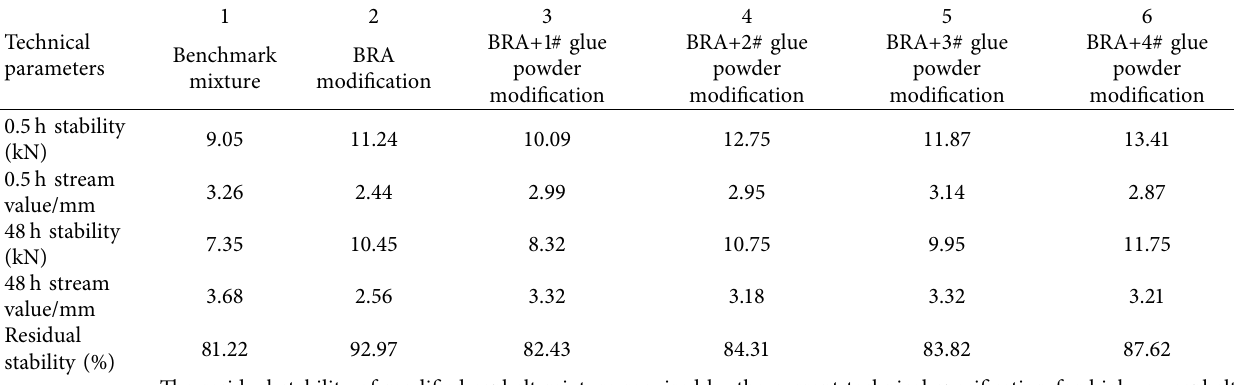
Figure 5: Curve of mechanical indexes of standard Marshall specimen. (a) Stability of standard Marshall specimen; (b) standard Marshall specimen flow value. Table 5: Determination of residual stability in each